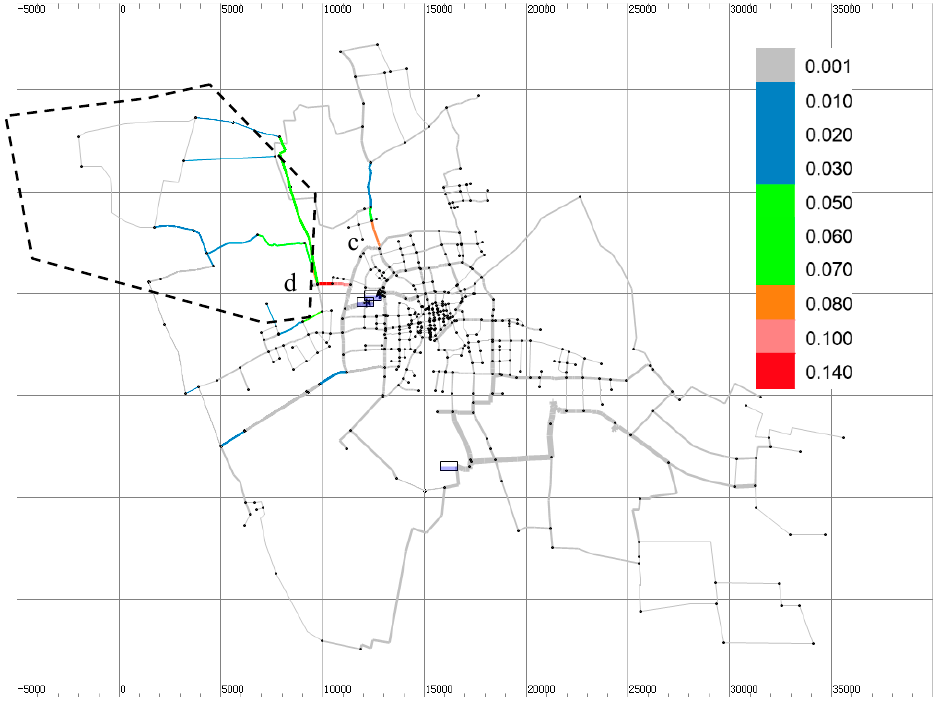
Figure 4. UIPF assessment in the northwestern region of J city.